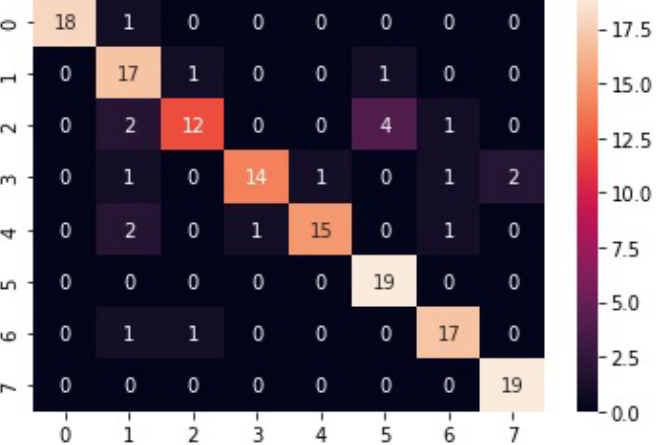
Figure 11. Random-forest-based confusion matrix.